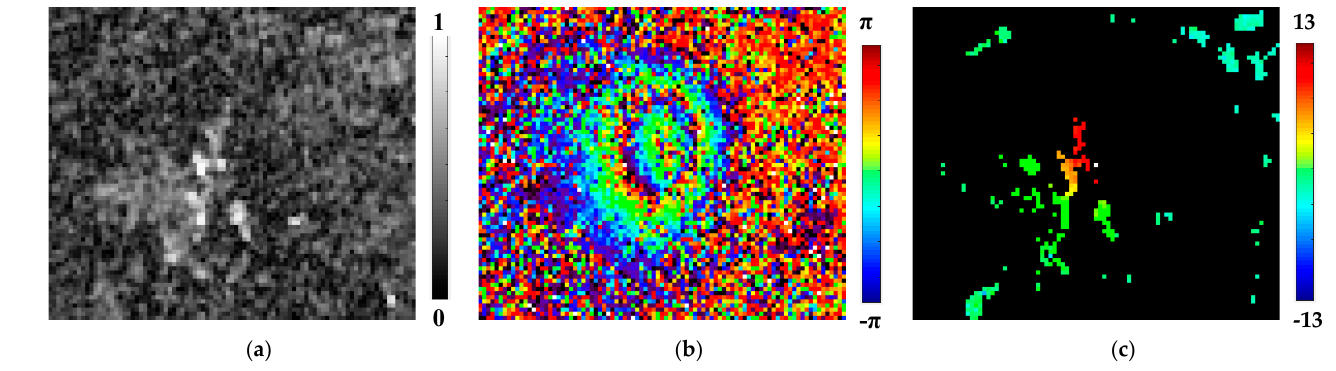
Figure 11. Mean amplitude ( a ), co-seismic wrapped ( b ), and unwrapped ( c ) interferograms of the Pieszkowice area in the vicinity of the PIES GNSS station and seismometer. Master image: 25 July 2020. Slave image: 31 July 2020. Descending trajectory. Vertices of the area: [51 ◦ 28 (cid:48) N, 16 ◦ 9 (cid:48) E–51 ◦ 29.4 (cid:48) N, 16 ◦ 7.2 (cid:48) E]. Color scales: [0–1] ( a ), [ − π , π ] ( b ), [ − 13, 13] rad ( c ).